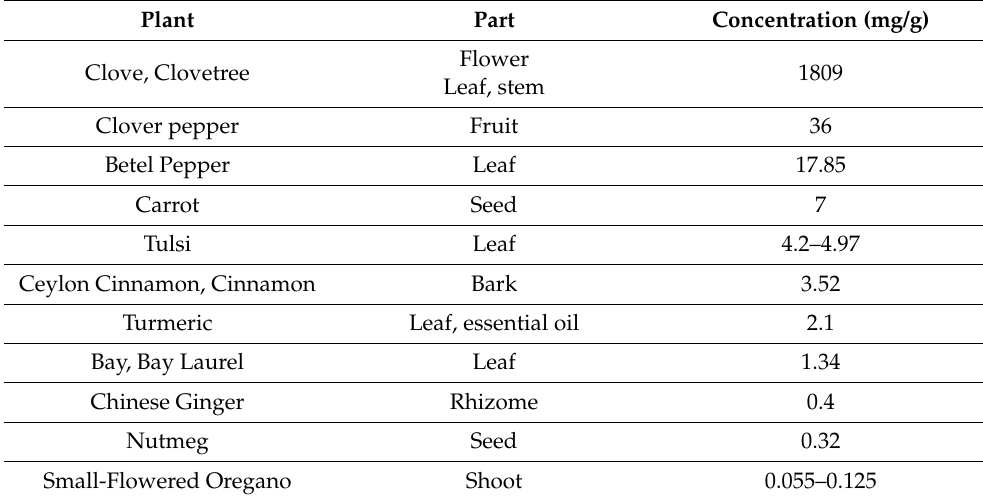
Table 1. Occurrence of eugenol and its concentration in particular parts of plants